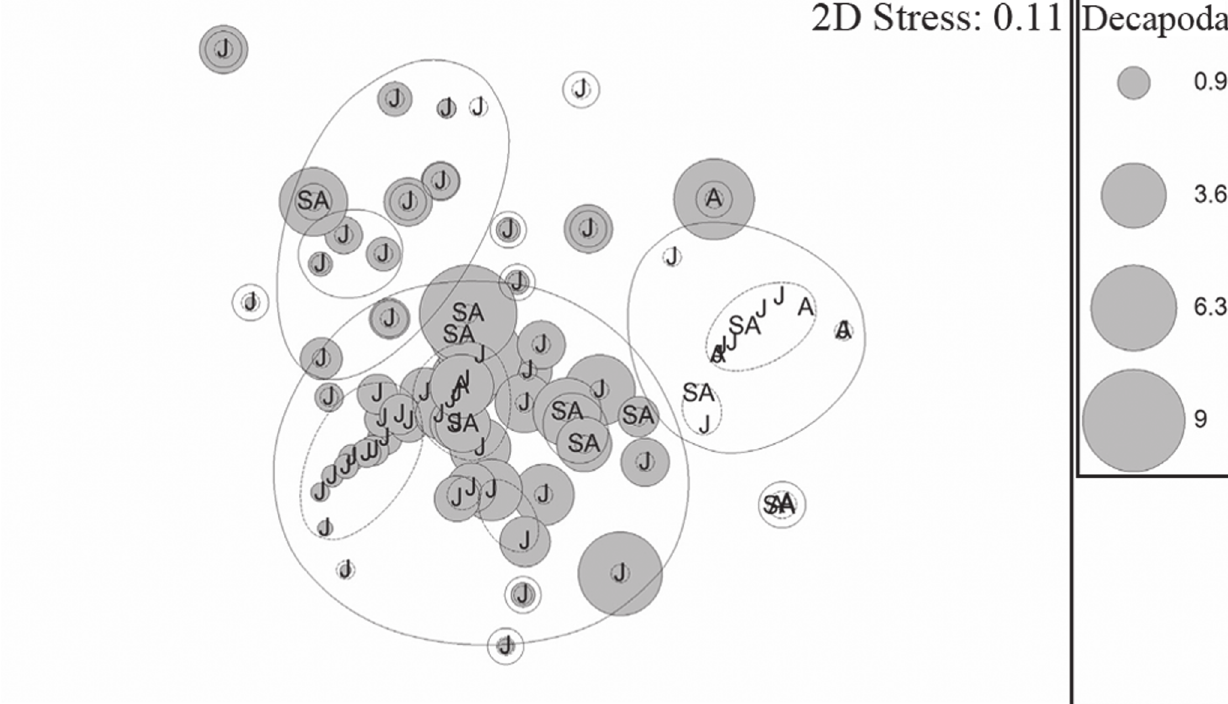
Fig. 3. Contribution of the food item Decapoda to Lutjanus analis diet, from Abrolhos Bank coral reefs, Eastern Brazil, between June 2005 and March 2007. The larger the bubble, the greater the percent participation of volume. J = juveniles; SA = sub-adults; A =